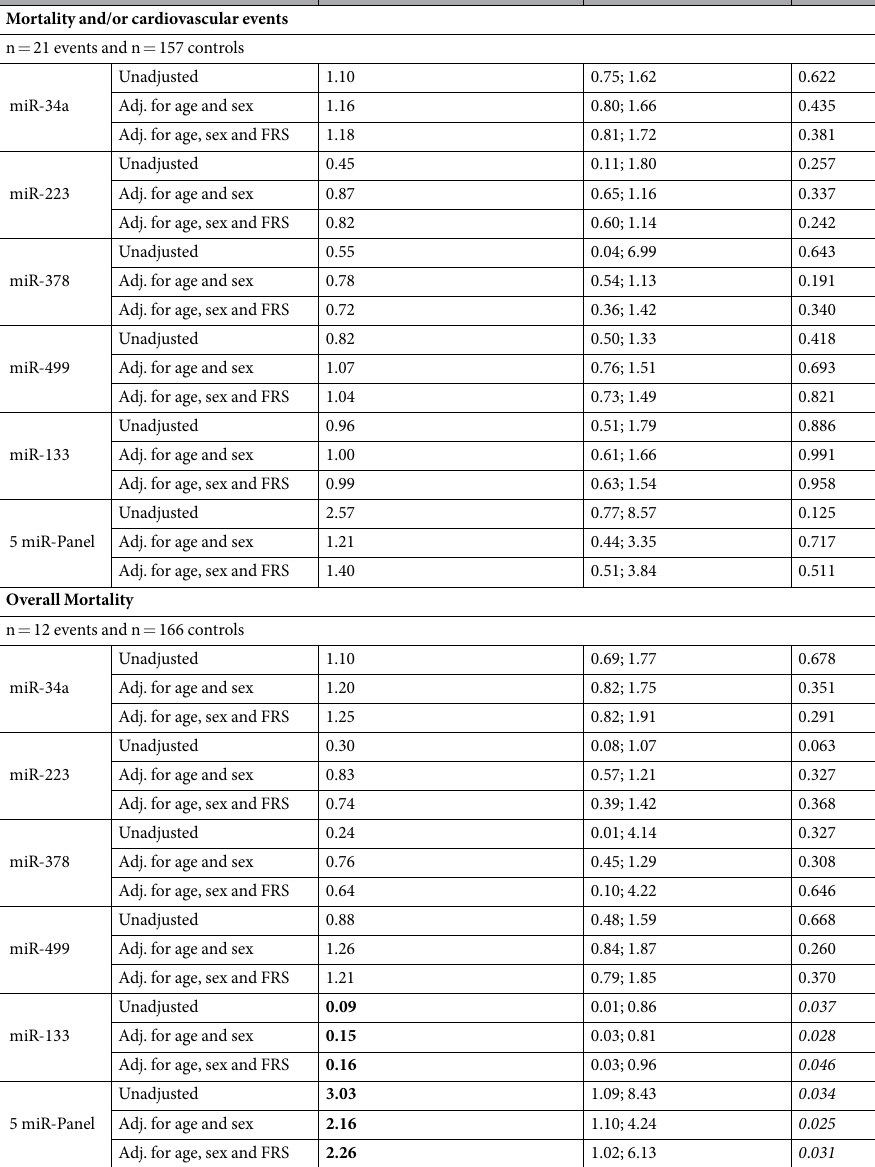
Table 2. Prognostic value of the 5 miRs and the respective Panel in the derivation study cohort (DETECT Study